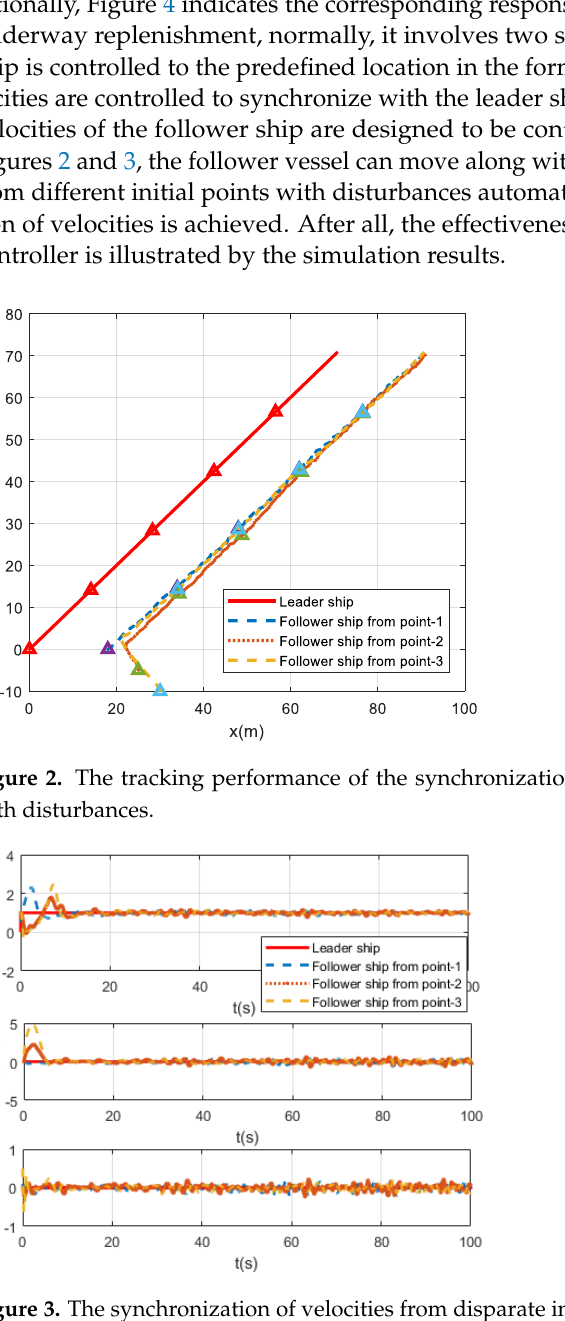
Figure 4. The responses of control inputs from disparate initial points with disturbances.